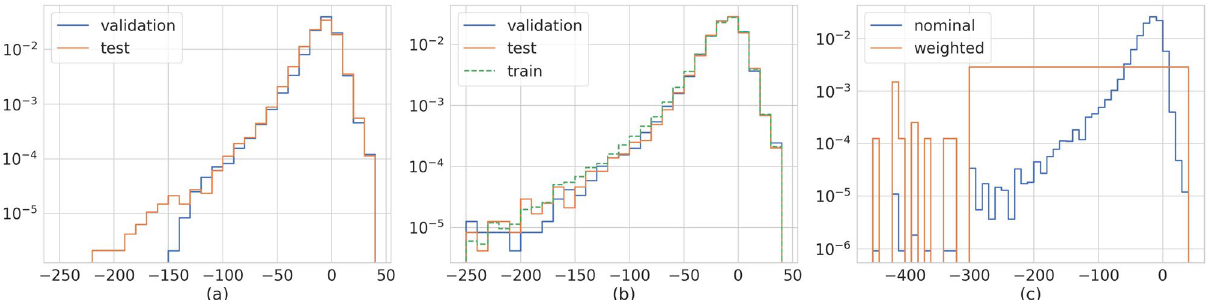
Figure 1. Normalized distributions of Dst in the dataset used for training, validation and test. ( a ) Validation is the first half of the solar cycle period, test the second half. ( b ) Points for validation and test are randomly extracted. Train dataset includes all the available points before 1/1/2009. ( c ) Train dataset without and with re-weighting the low Dst